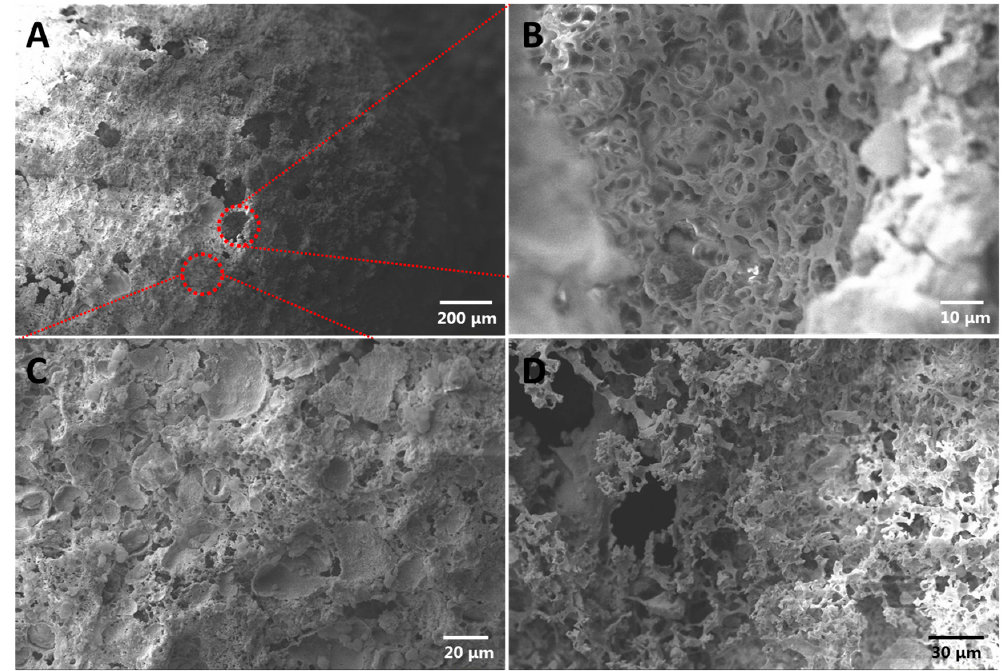
Figure 3. SEM images of prepared cellular capsule derived from Pickering emulsion-based marbles (P 0.02-0.1-2 ): ( A ) Overall morphology of prepared cellular capsules; ( B ) Internal cellular structure of the capsule from the perspective of large hole distributing on the surface; ( C ) Surface morphology of the capsule; ( D ) Inner structure of the capsule after incision.